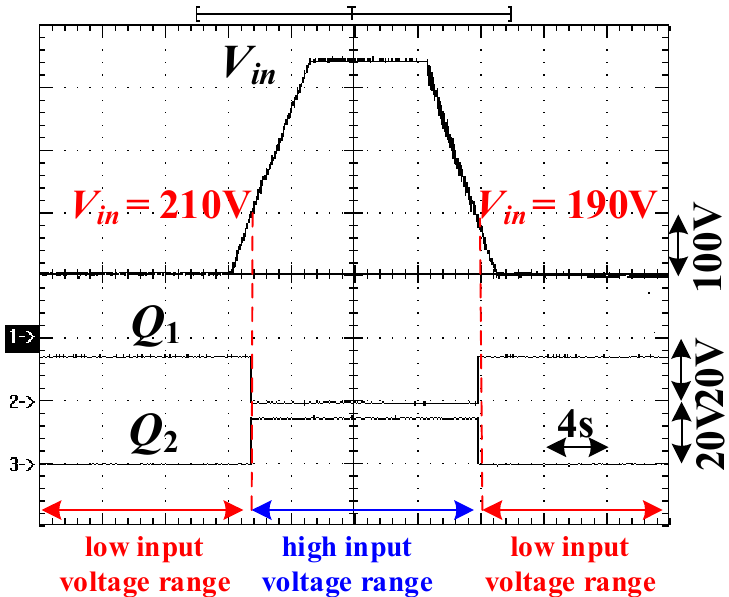
Figure 14. Measured waveforms of input voltage and PWM signals of Q 1 and Q 2 under 100% load.